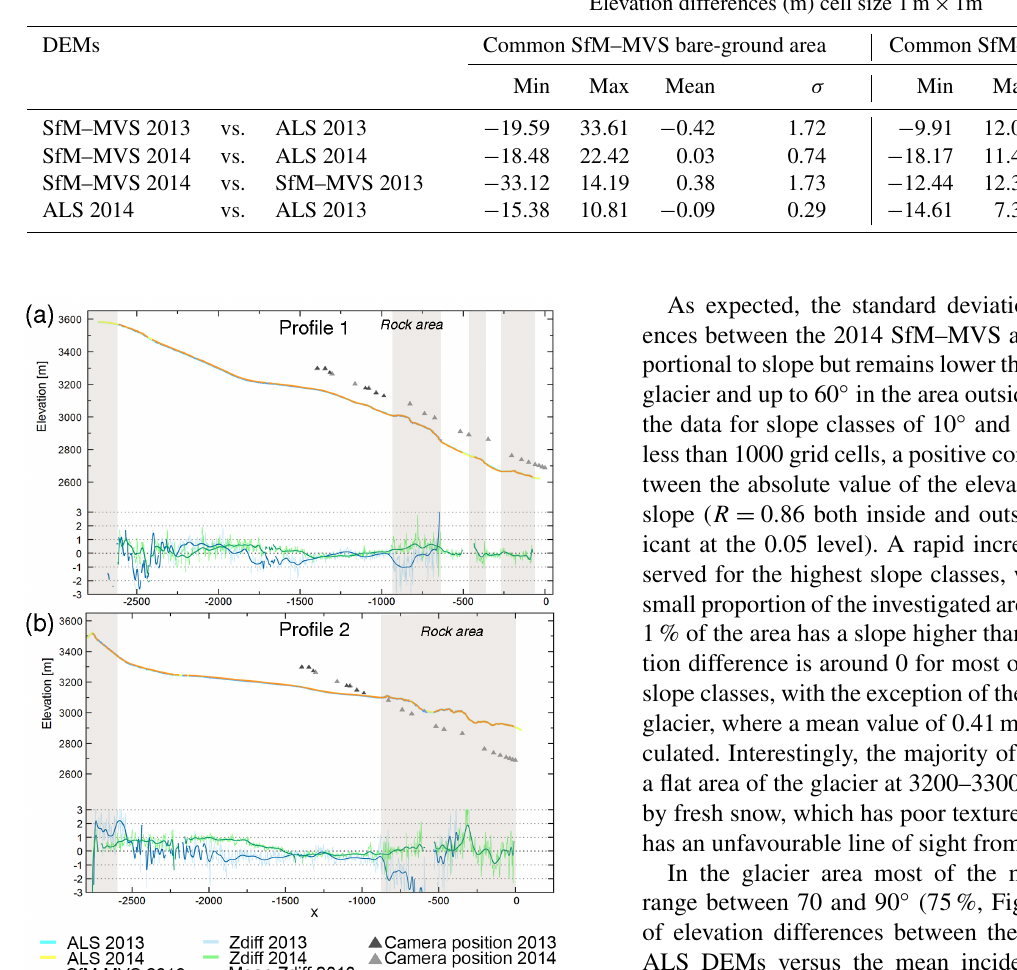
Certain outliers can be observed in steep areas outside the glaciers, even after filtering, but they likely have no influence on the glacier, where the slope is much